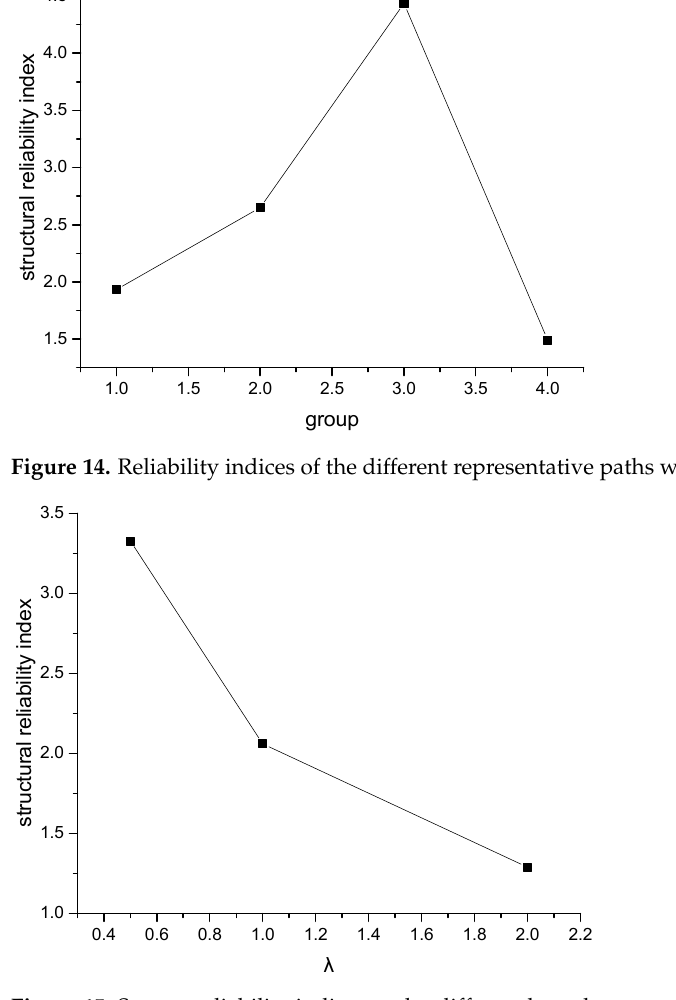
Figure 15. System reliability indices under different lateral pressure coefficients.